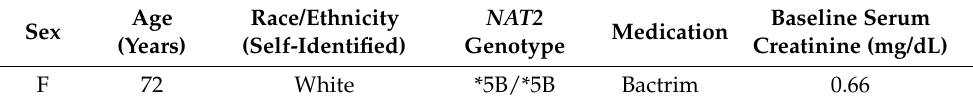
Table 3. Pre-emptive NAT2 genetic testing prior to prescribing Bactrim.